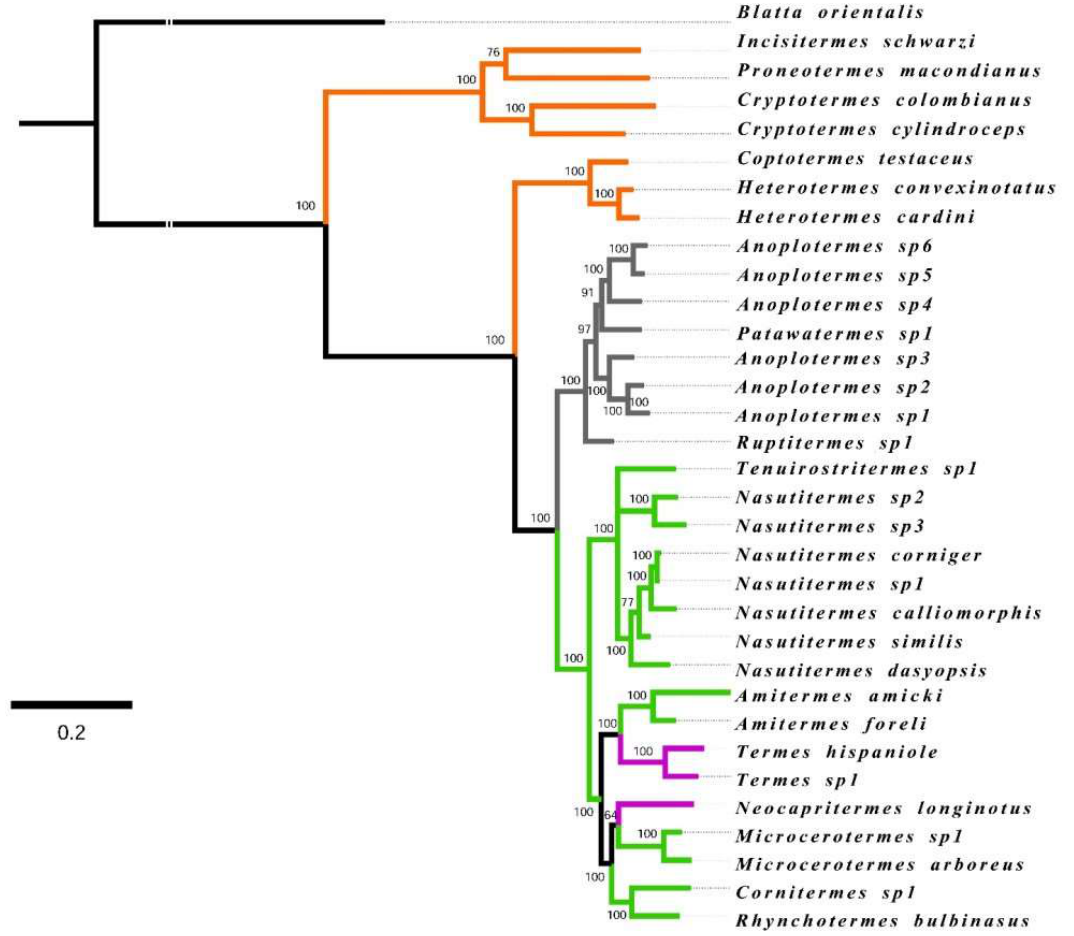
Figure A1. Phylogenetic tree inferred from COII, 12S, and 16S sequence data (nodes show Bayesian posterior probability support, BPP). Red: Kalotermitidae, Blue: Rhinotermitidae, Green: Termitidae. Outgroup: Blatta orientalis .